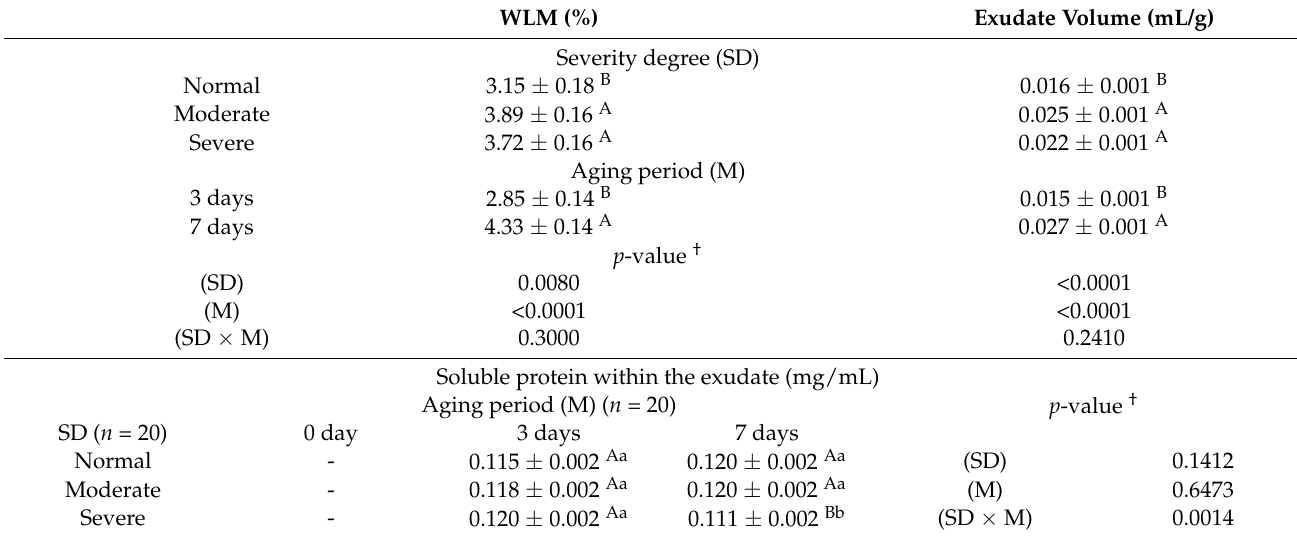
Table 3. Mean values of weight loss by aging (WLM), exudate, and soluble protein volumes within the exudate of breast meat from broilers affected by wooden breast myopathy maturated for up to 7